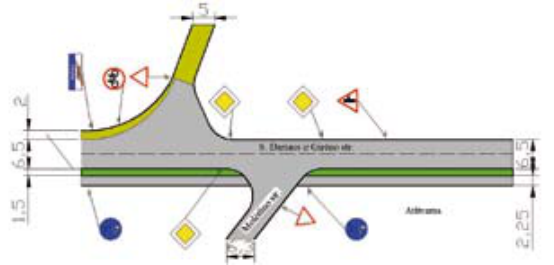
Fig. 3. The existing street configuration and the main geometrical parameters